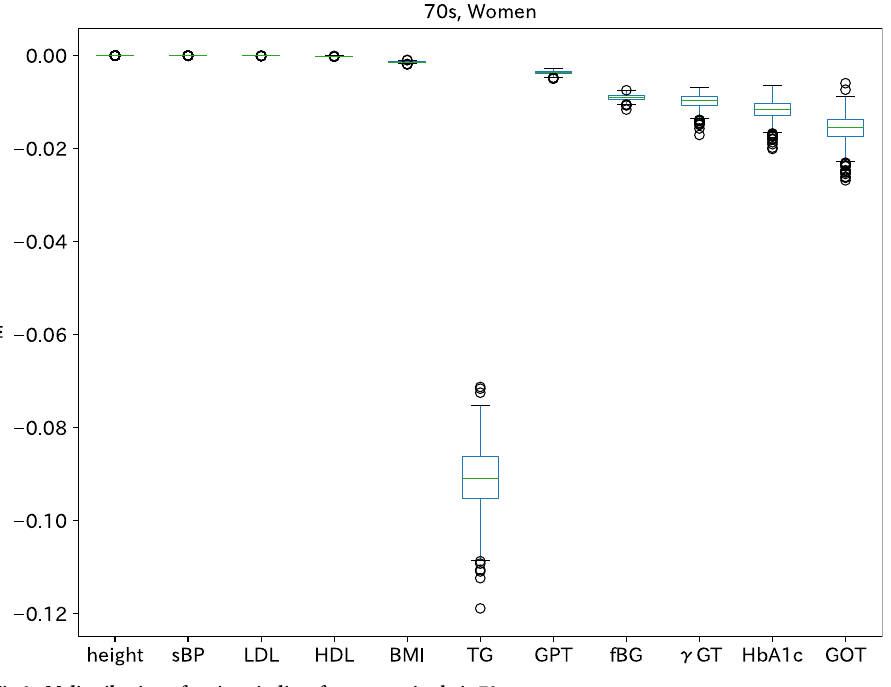
Fig 2. M distribution of various indices for women in their 70s.